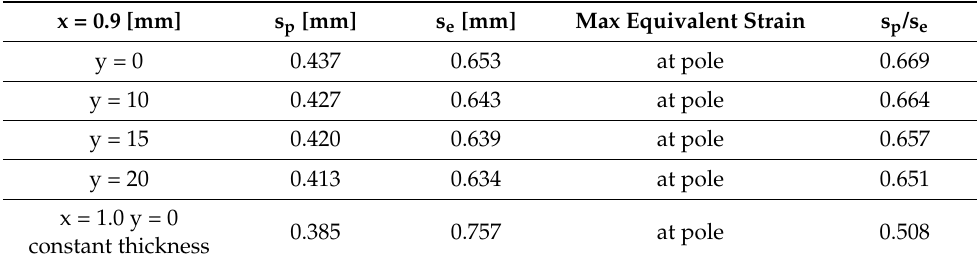
Table 2. FEM optimization analysis for different values of y